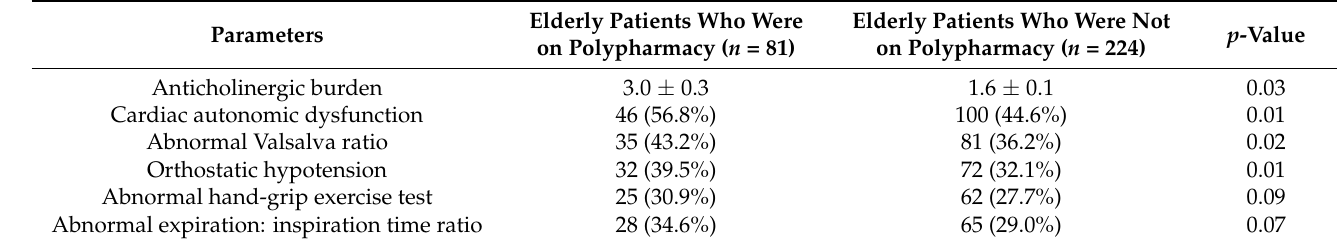
Table 2. Comparison of the anticholinergic burden and proportion of patients with cardiac autonomic dysfunction between elderly patients who were on polypharmacy and those who were not ( n = 305).